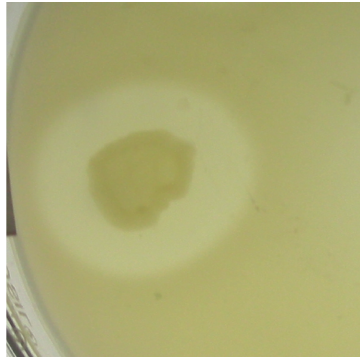
Figure 1: Protease activity shown by the Aeromonas hydrophila strain An4.